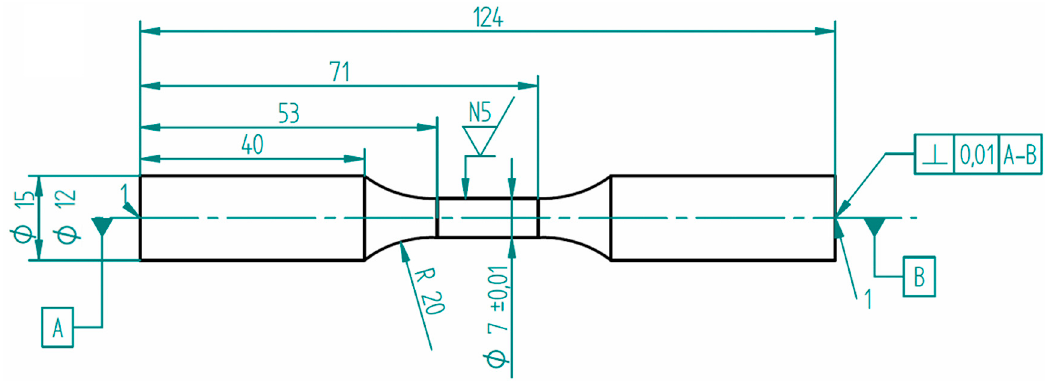
Figure 1. Specimen geometry. Only the cylindrical gauge section is considered in Finite Element Analysis (FEA) simulations.